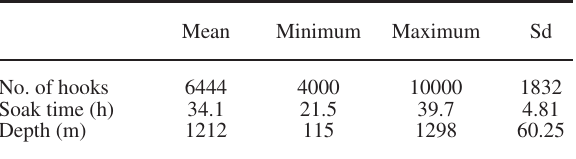
Table 5. – descriptive statistics of continuous variables observed on sampled trips (n=14) onboard longline vessels. sd, standard